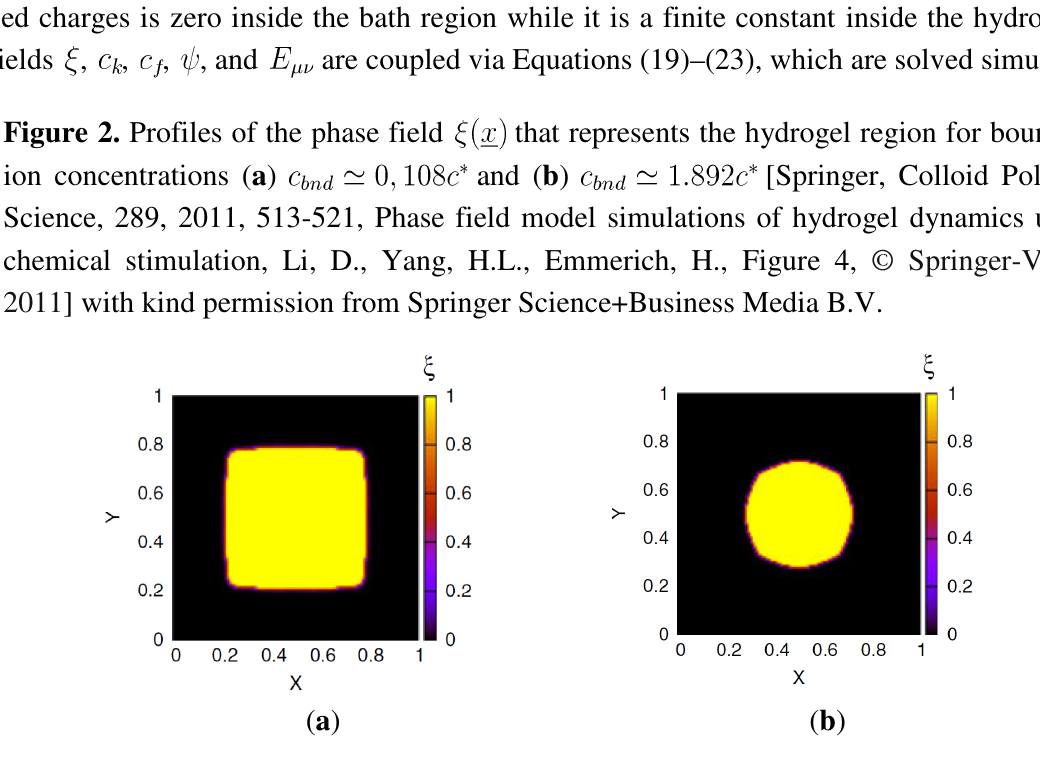
Figure 2. Profiles of the phase